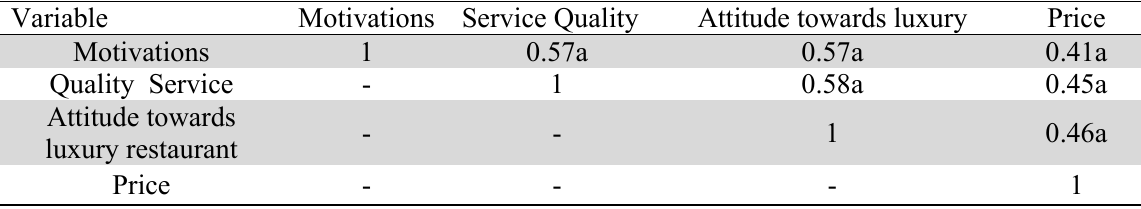
Correlation between the research variables (p <0.01)